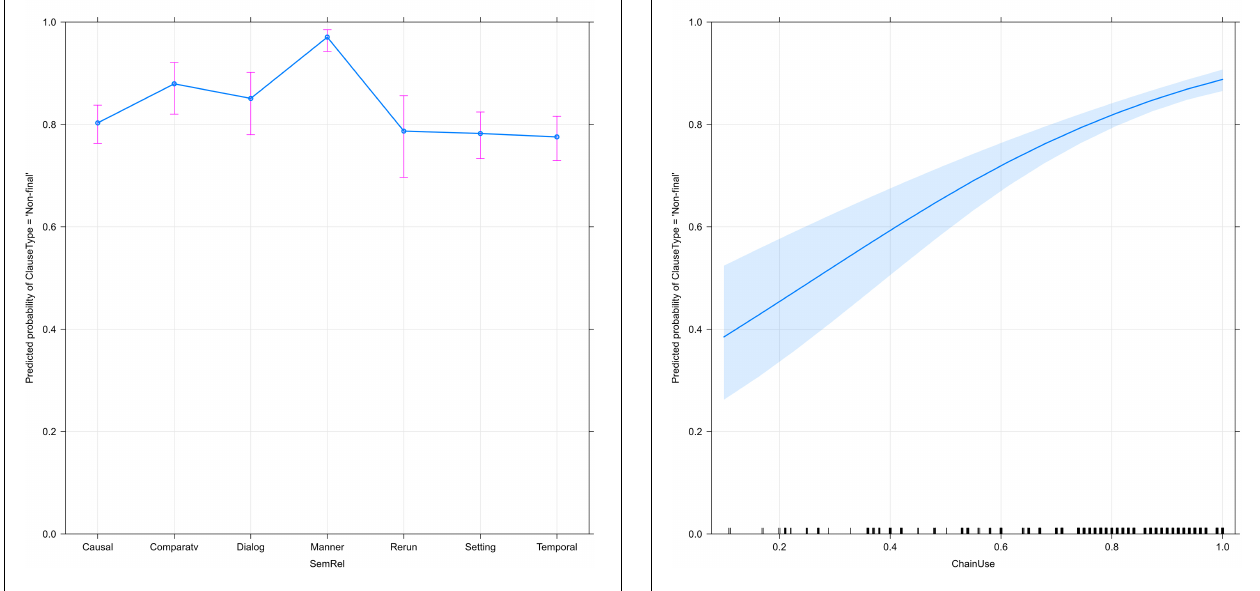
FIGURE 4 | An increase in the percentage of chained clauses (ChainUse) in stories necessarily increases the probability of clause linking (ClauseType = ‘Non-final’). The ticks along the x -axis show that the densest concentration of stories is at the high end of the scale: 74–100% chained clauses.